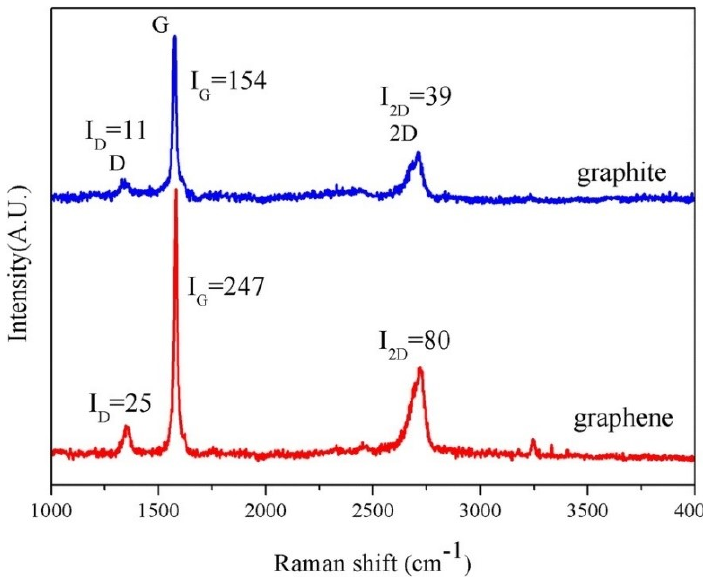
Figure 5. Raman spectroscopy of the bulk graphite and graphene [140] (CC BY).